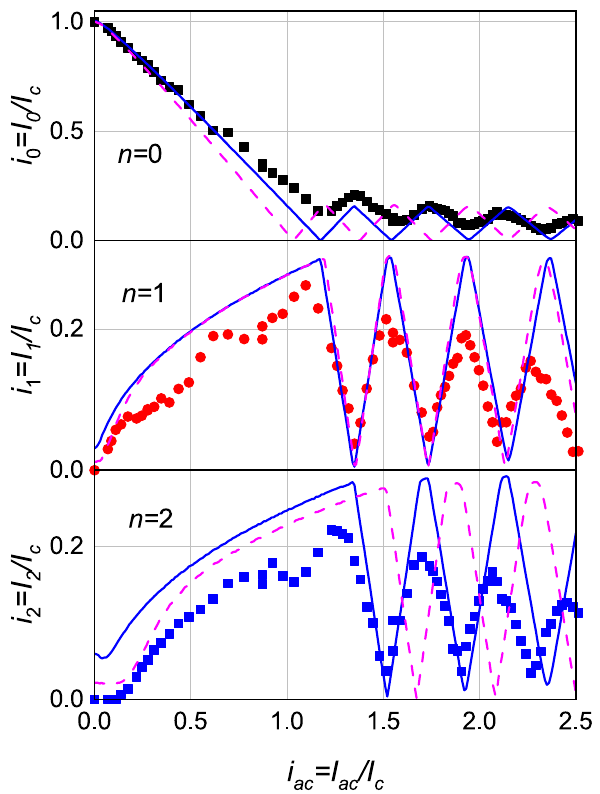
Figure 7. Fit of the measured oscillations of the current steps of point contact No. 1 (symbols) by means of the dependencies calculated from the RSJ model, reported in Eq. (1), by using � ϕ = 0.15 ( I s = I c sin (ϕ) , solid blue line) and � 2 ϕ = 0.34 ( I s = I c sin ( 2 ϕ) , dash magenta line). � ϕ and � 2 ϕ were determined from the graph √ exp ∗ P ) and i calc − 2 ϕ n ( h ∗ i ac ) were scaled by the coefficients k ∗ = 2.76 and of Fig. 6. The abscissae of graphs i n ( k h ∗ = 1.15 , respectively, to have the first minimum of all dependencies i 1